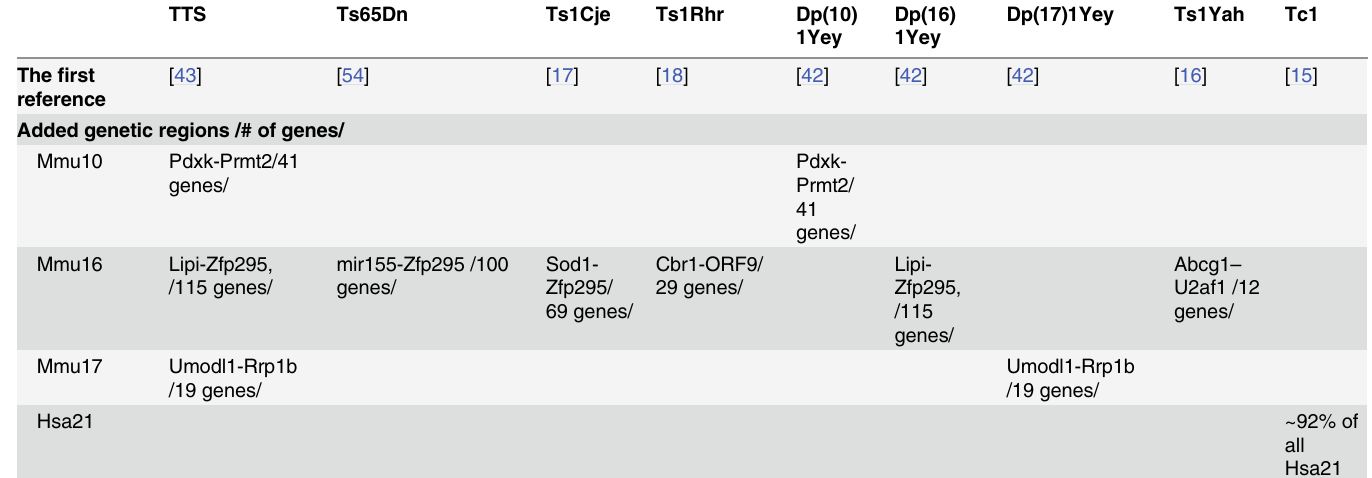
Table 1. Major behavioral and physiological phenotypes in mouse genetic models of Down